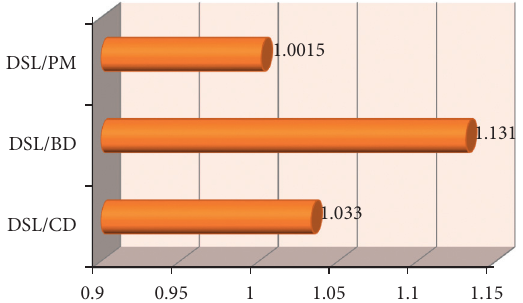
Figure 5: CRs of the briquettes with different binders.